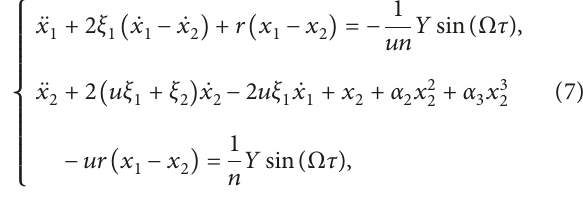
Figure 9: Effects of the damping parameters ξ 1 and ξ 2 on the frequency response curves: (a) response amplitude of reaction mass; (b) response amplitude of baseplate.